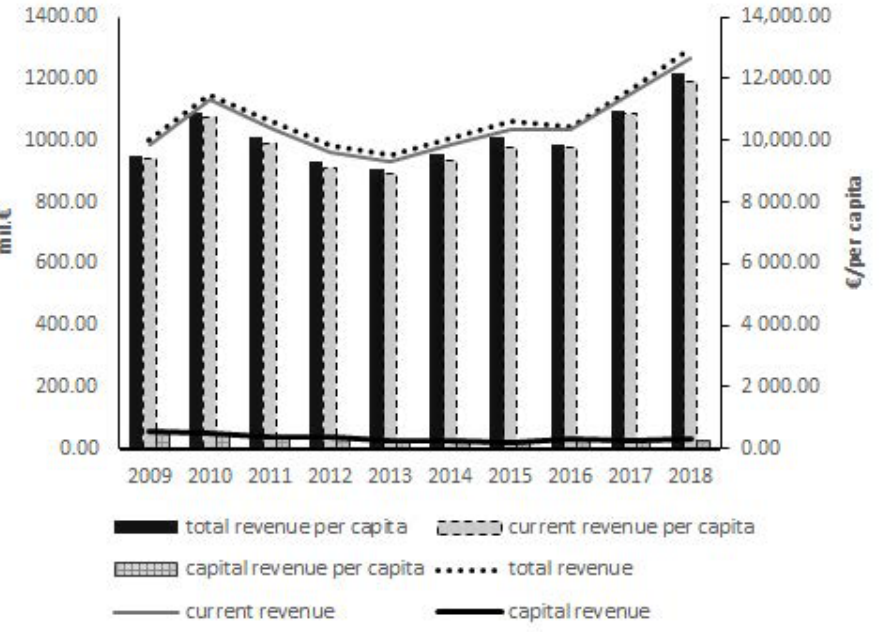
Figure 2. The development of total revenues, current revenues, and capital revenues of the municipalities in the Czech Republic, in the time period 2009–2018, Source: Czech Statistical Office (2020), own